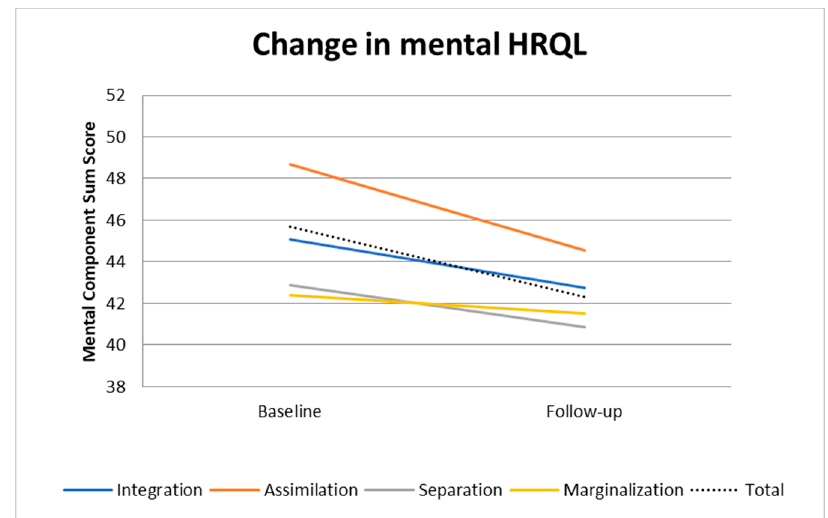
Figure 2. Change over time in mental component summary score (MCS) by acculturation status, adjusted for age, sex, education and income (predictive margins).